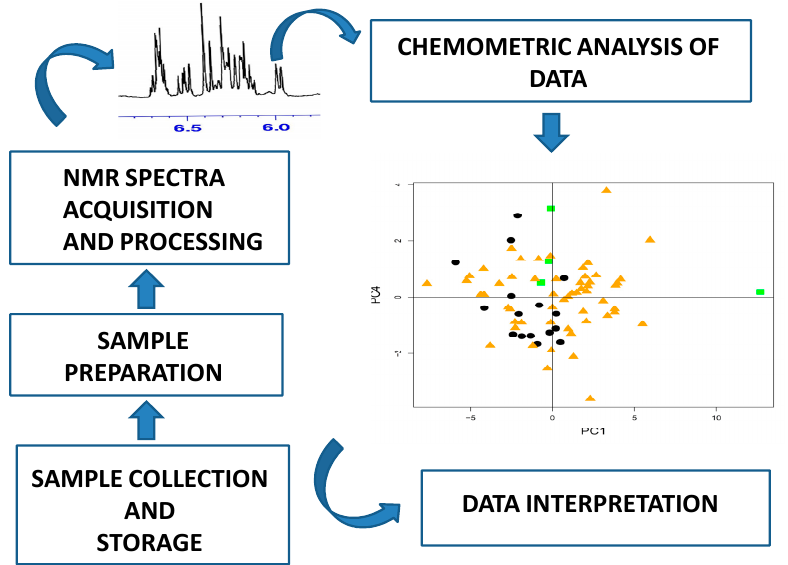
Figure 2. Schematic depiction of a typical NMR metabonomics experiment in food